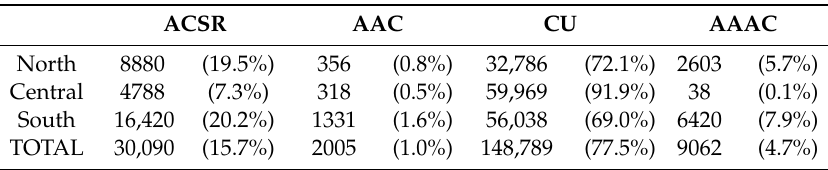
Table 3. Italian distribution network (MV and LV) main wire types extension in (km) and (%) respective to the total lines extension.